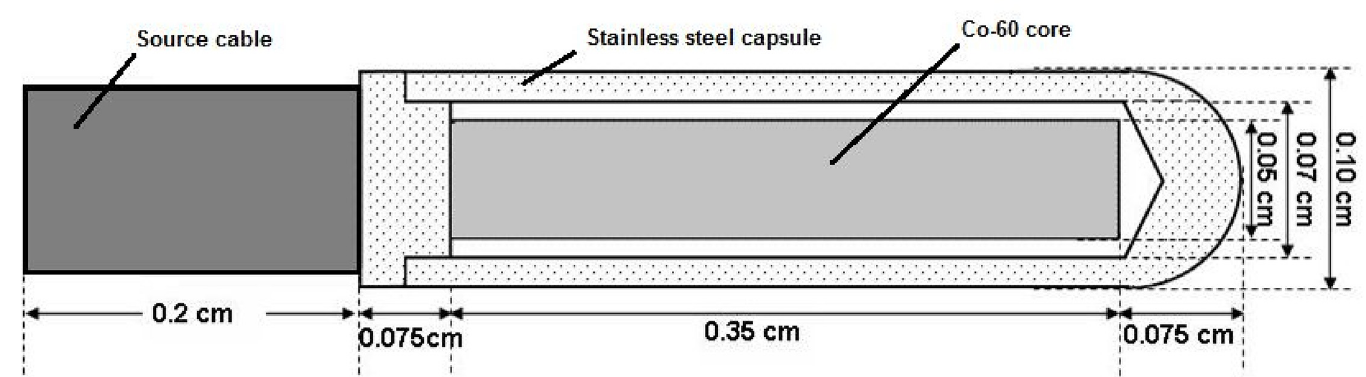
Fig 1. Geometry design of the 60 Co source model Co0.A86. The coordinate axes in this study are also shown with their origin at the geometric center of the active volume. The dimensions are in millimeters [8].